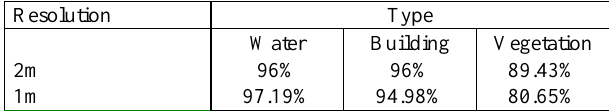
Table 1. GoogLeNet model validation accuracy at different resampling resolutions